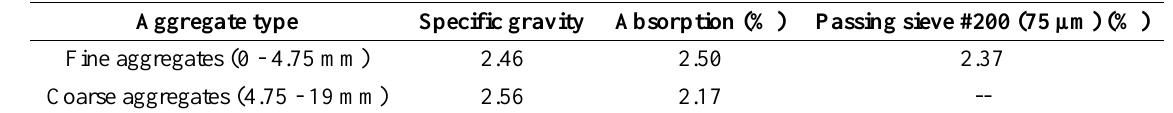
Fig. 1. Particle size distribution of cementitious materials Table 4. Aggregate properties